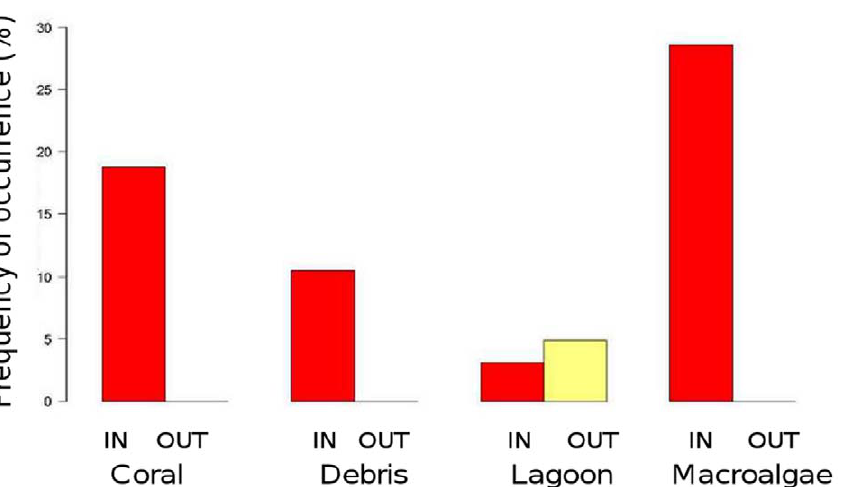
Figure 10. Frequency of occurrence of sharks. Frequencies were plotted per habitat (labeled on the X-axis) and per protection status (protected areas in dark grey and unprotected areas in light grey).